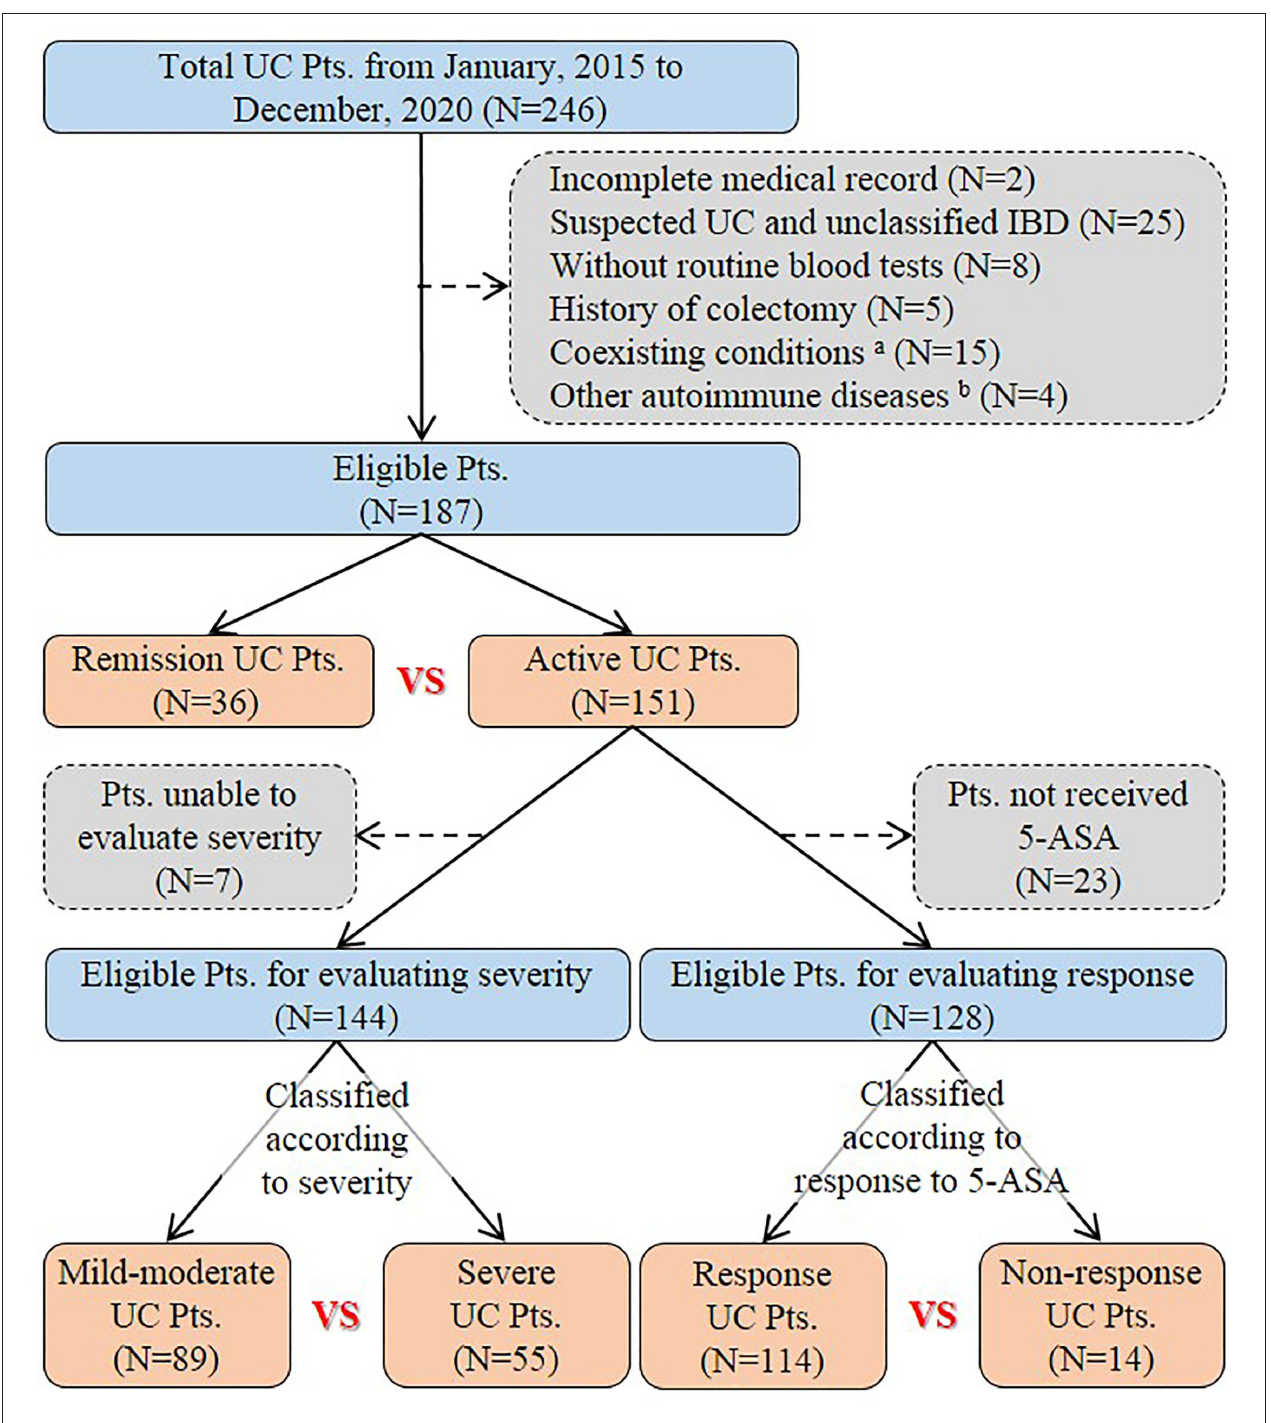
FIGURE 1 | Flowchart of patient selection. a Patients had coexisting conditions that potentially influence inflammatory indexes, including severe trauma ( n = 1), pregnancy ( n = 1), liver cirrhosis ( n = 2), uremia ( n = 1), and malignancy (n = 10). b Four patients had other autoimmune diseases, including psoriasis ( n = 1), Behcet’s disease ( n = 1), urticarial vasculitis ( n = 1), and rheumatoid arthritis ( n = 1). UC, Ulcerative colitis; Pts, Patients; IBD, Inflammatory bowel disease; 5-ASA, 5-aminosalicylic acid.